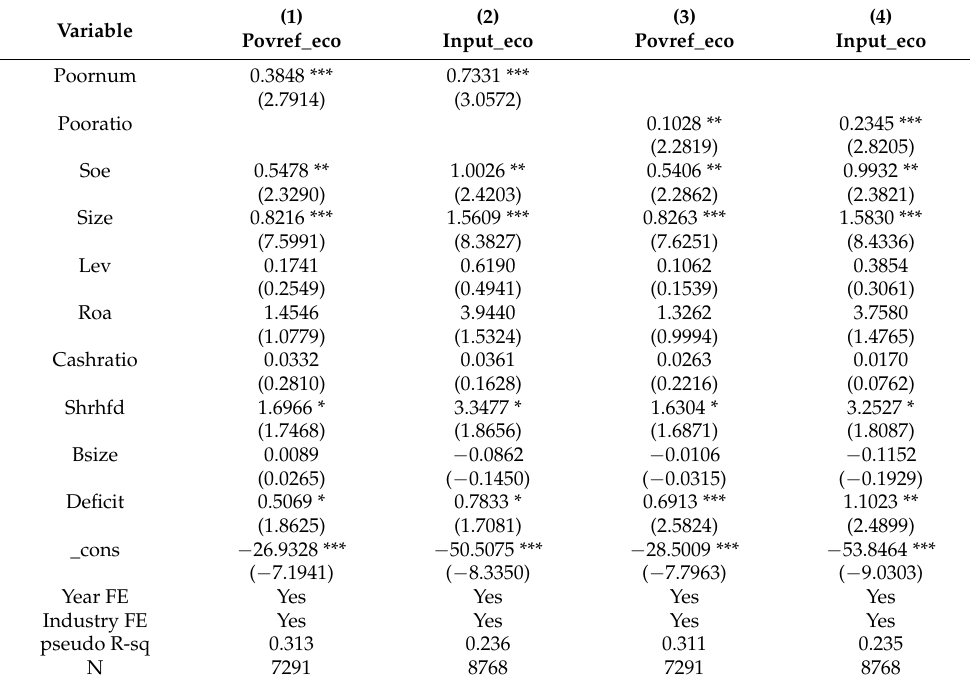
Table 7. Robustness tests: changing the measurement of importance of